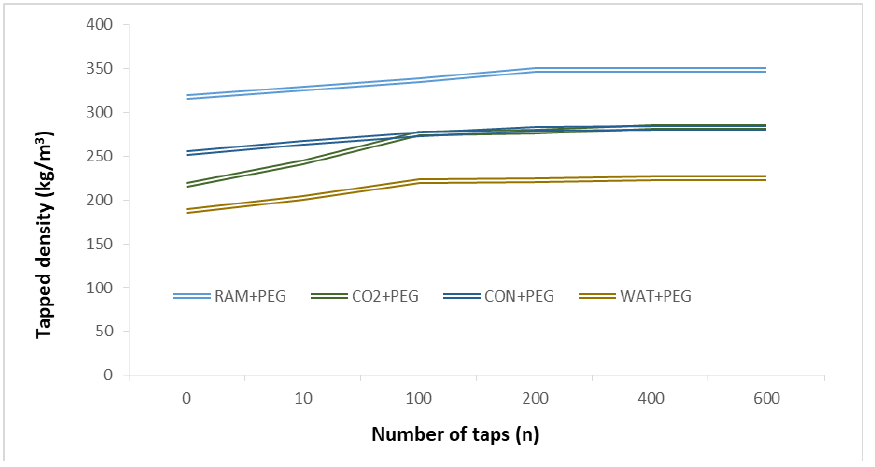
Figure 6. Tapped density vs. number of taps of PEG microparticles of pigments of raw algal materials or extracts obtained with different extraction techniques: RAM+PEG—raw algal material, SCO 2 E+PEG—extract obtained with supercritical extraction, CON+PEG—dry extract obtained with conventional extraction, WAT+PEG—dry extract obtained with ethanol/water extraction, PEG— polyethylene glycol.